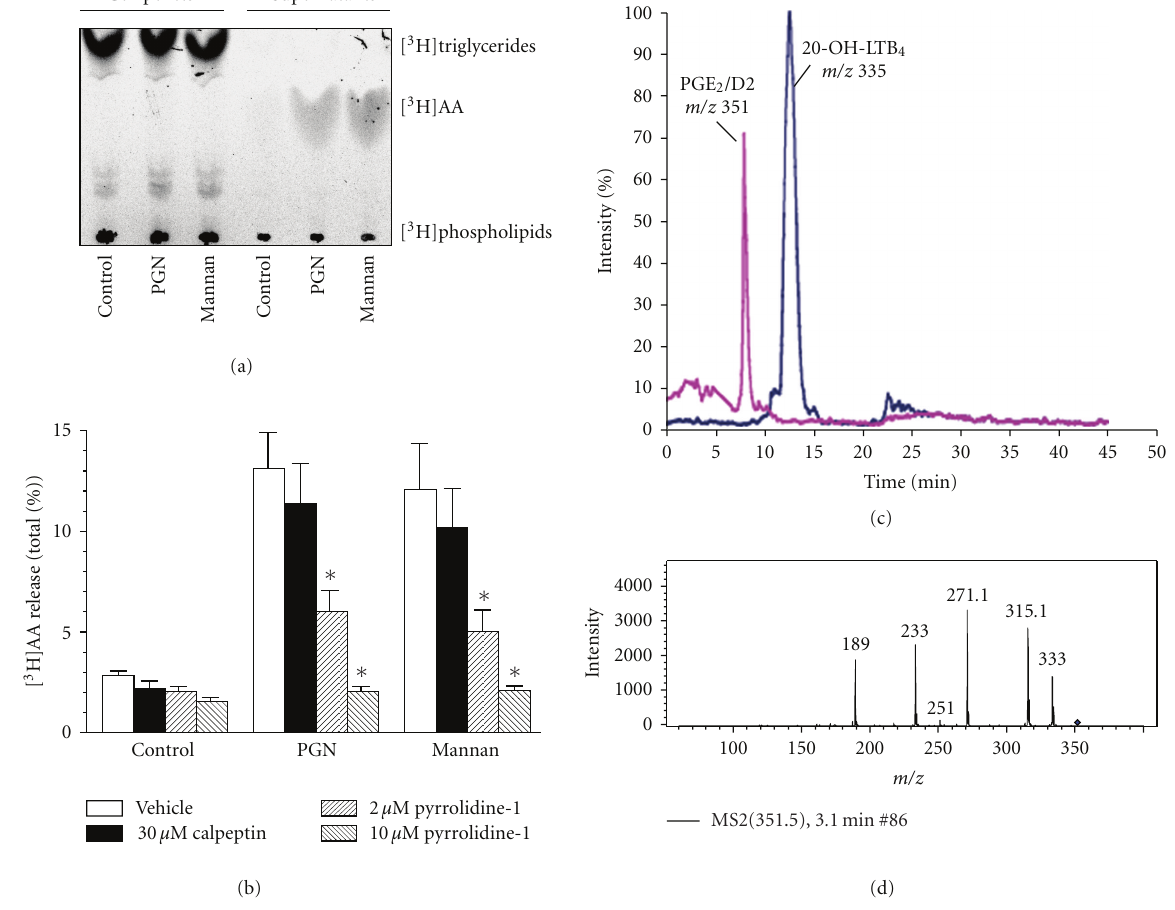
Figure 1: Distribution of [ 3 H]AA label in the di ff erent lipid fractions in PMN and supernatants. PMN at a concentration of 10 7 cells/ml were labelled with 0.2 μ Ci of [ 3 H]AA and stimulated for 1 hour in the presence of 10 μ g/ml PGN or 25mg/ml mannan, or left untreated. PMN and supernatants were subjected separately to extraction in chloroform/methanol (1 : 2, v/v), according to the Bligh and Dyer procedure. The lipids extracted into the chloroform layer were dried under N 2 stream and developed by thin layer chromatography on silica gel plates in the system n-hexane/diethyl ether/acetic acid (70 : 30 : 1, v/v). The radioactivity distributed in the di ff erent lipid fractions was quantitated using K/tritium imaging screens. The migration of the standards is indicated (a). Cells were incubated with calpeptin and pyrrolidine- 1 prior to the addition of the stimuli and the [ 3 H]AA released into the cell supernatants assayed. Data represent mean ± SEM of three experiments in duplicate. ∗ P < 0 . 05. Reproduced with permission [10] (b). Chromatogram of a supernatant of human PMN stimulated with mannan showing the retention times of PGE 2 /PGD 2 and 20-OH-LTB 4 . Both compounds have been identified by their mass spectra (c). Fragmentation spectra in the negative ion model using MRM (multiple reaction monitoring) of the specific transitions m/z 335–195 for LTB 4 , m/z 351–195 for 20-OH-LTB 4 , m/z 303–205 for arachidonic acid, m/z 351–189 for PGE 2 /PGD 2 are shown in